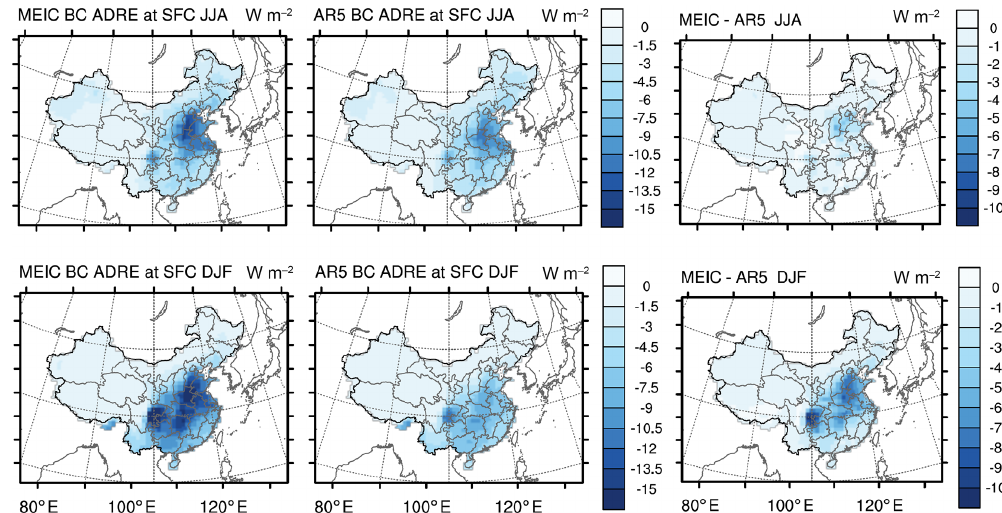
Figure 13. Spatial distributions of ADREs of BC in summer (June, July, August) and winter (December, January, February) at the surface (SFC) in year 2009.